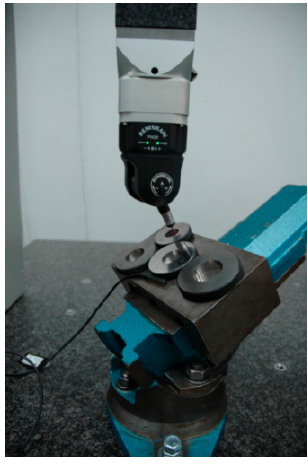
Figure 3. Measurements of standard ring in one of the selected positions.